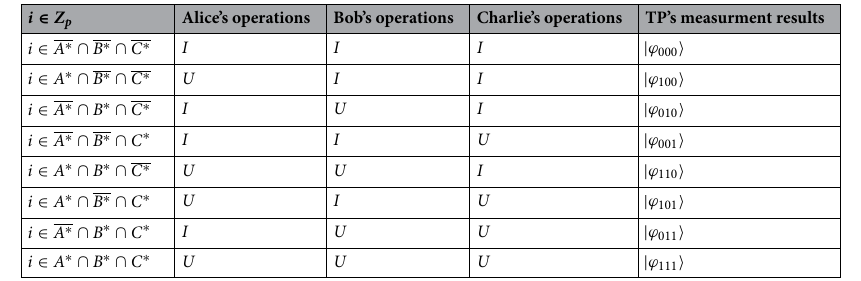
Table 1. The relationship between i and three parties’ operations.